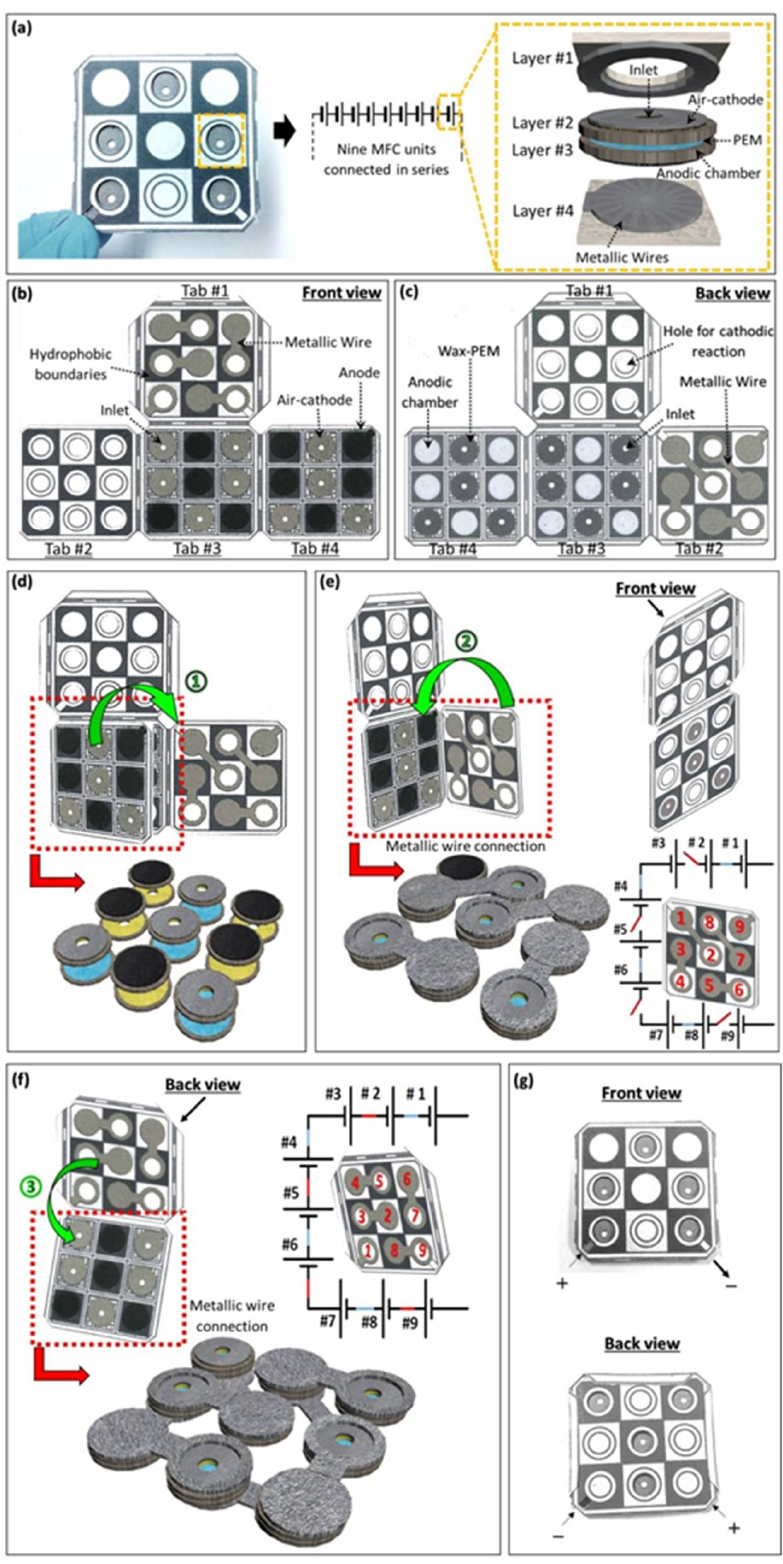
Figure 1. ( a ) An origami paper-based biobattery stack and schematic diagram of a cross-section of the single unit; ( b ) Front and ( c ) back view of the two-dimensional (2-D) sheet of paper before folding; ( d – f ) Folding processes for the three-dimensional (3-D) battery stack and its metallic wire configuration; ( g ) Front and back view of the folded battery stack.